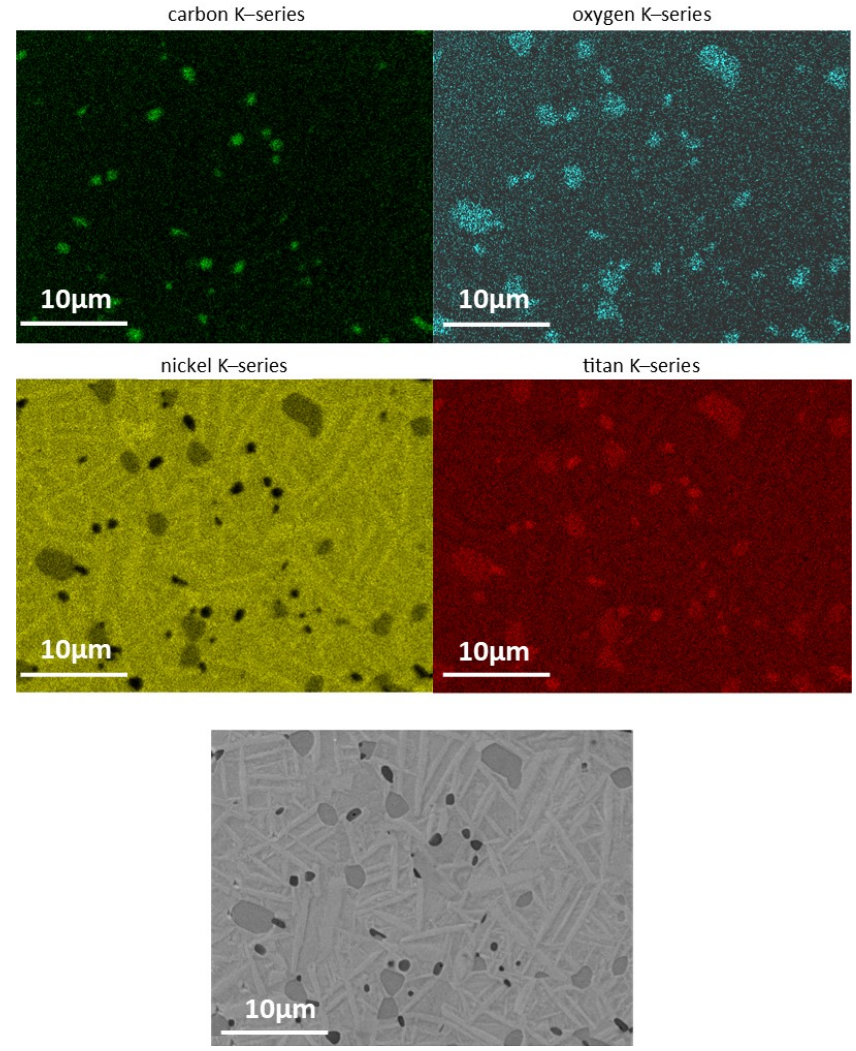
Figure 10. EDS mapping of an as-sintered FFF specimen